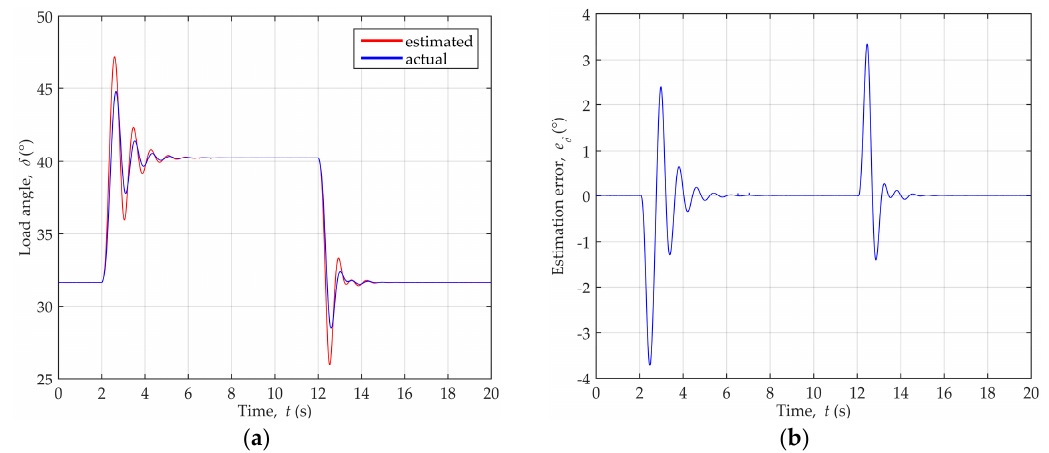
Figure 9. Load angle variation during dynamic disturbances of reactive power for generator operating point P = 0.89, Q = 0: ( a ) Comparison of the actual and estimated load angle values; ( b ) Load angle estimation error.